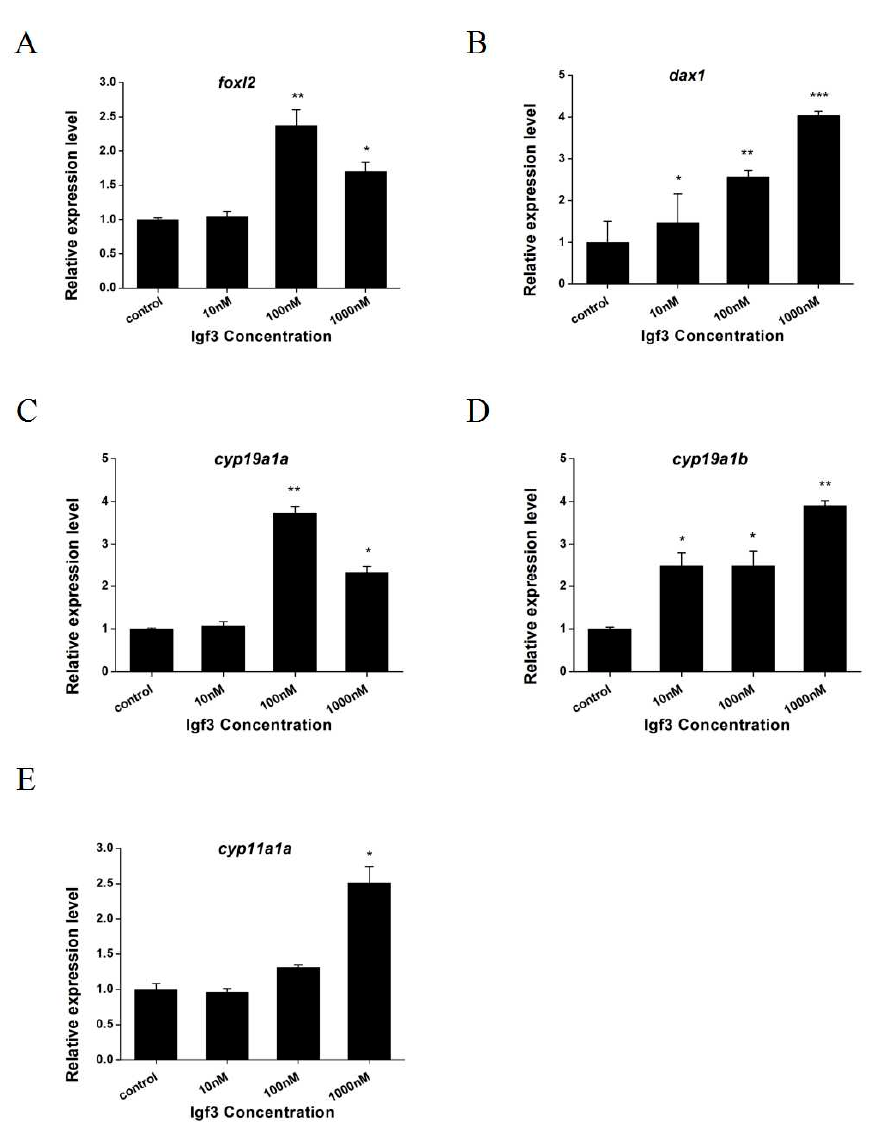
Figure 7. Igf3 added to primary ovarian cells increases expression of sex differentiation-related